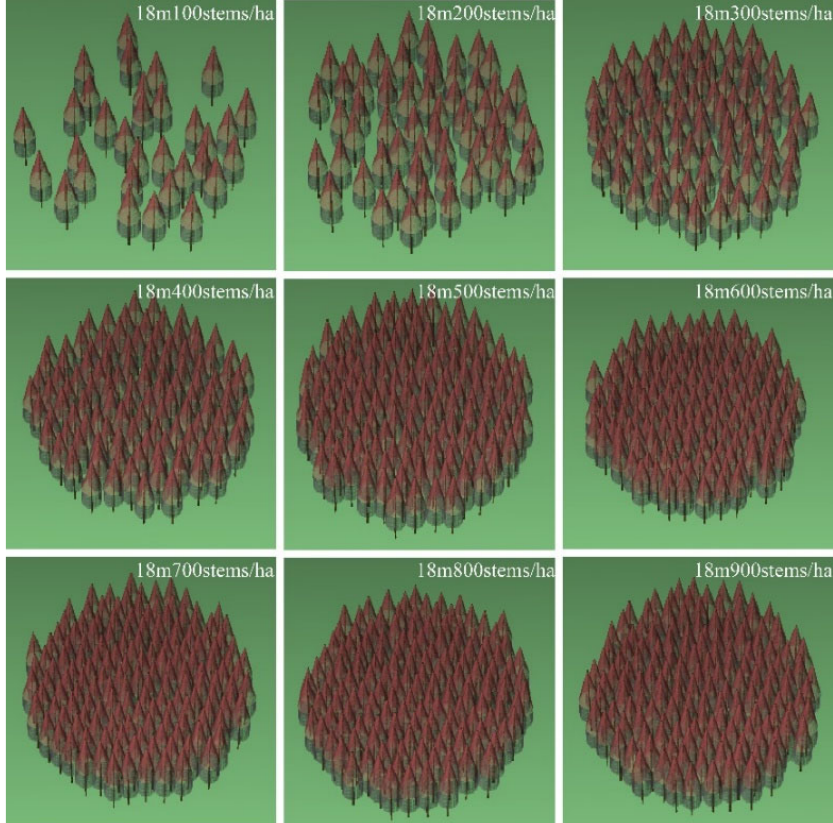
Figure 1. Scenarios of simulation for nine groups of simulated data. The reference height for all nine datasets is 18 meters. Forest density ranges from 100 to 900 stems/ha.